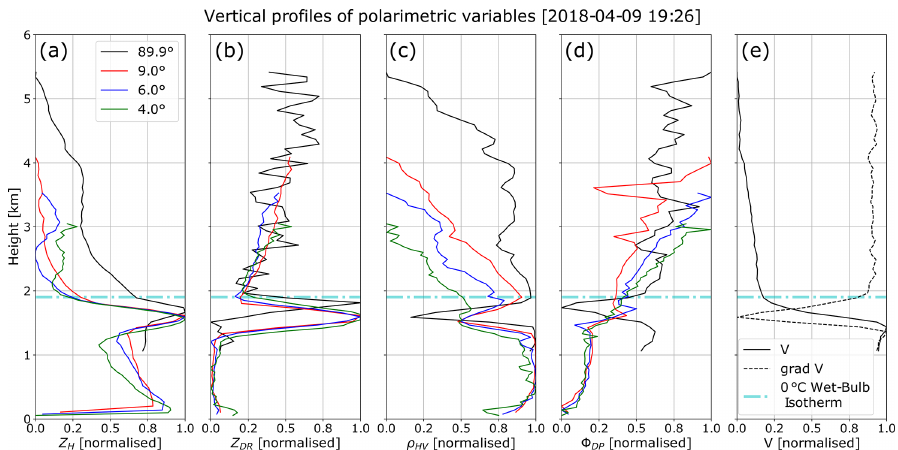
Figure 3. Normalised version of VPs and QVPs generated from polarimetric scans recorded at different elevation angles, related to a stratiform-type rain event. The 0 ◦ C wet-bulb height is shown with the dashed–dotted